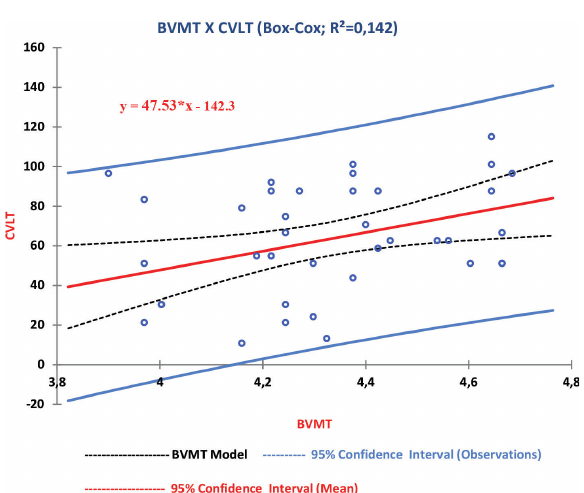
Figure 1. Regression BVMT-R × SDMT.